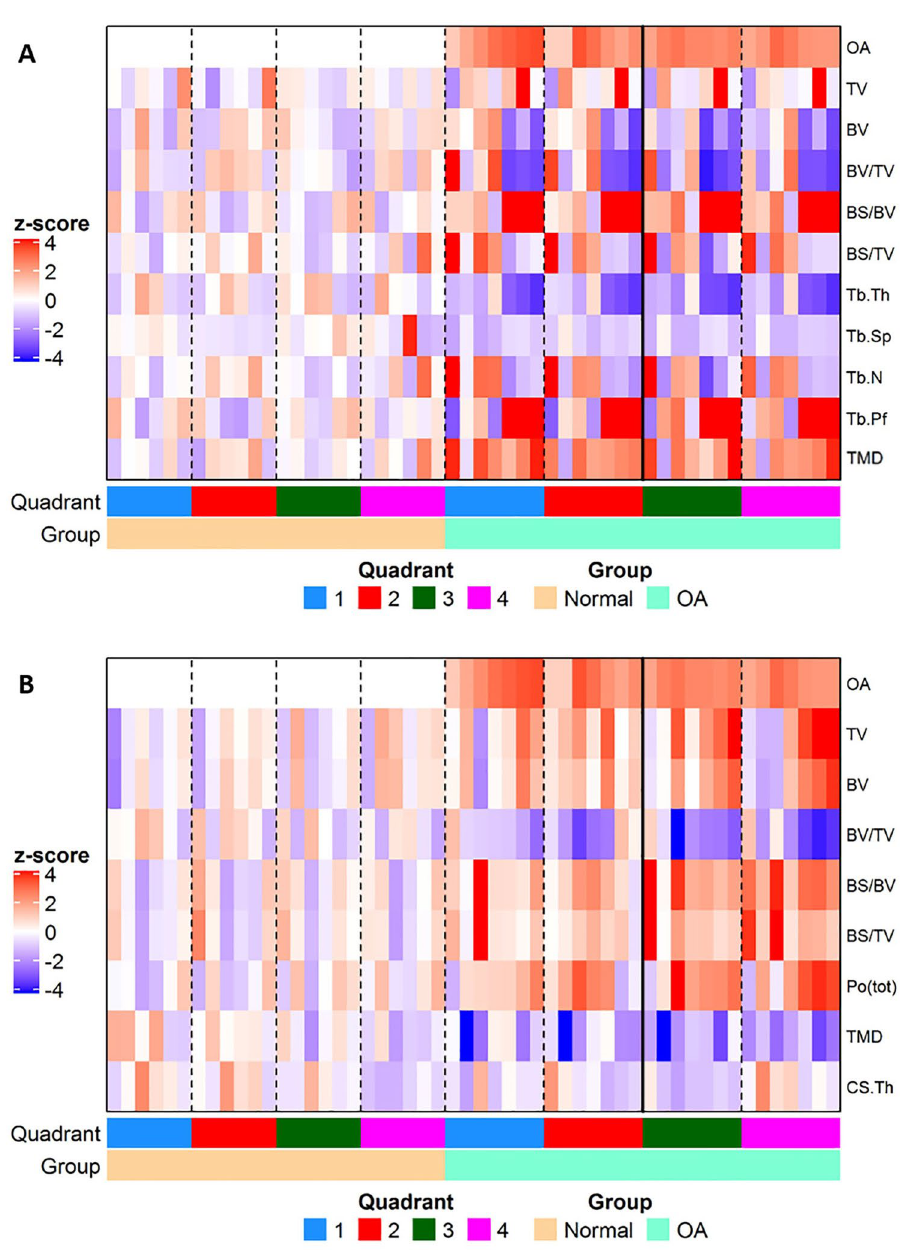
Figure 4. Heat maps showing differences in structural parameters of ( A ) trabecular bone and ( B ) subchondral plate in the four anatomical regions defined in both OA and non-OA samples. Patients were grouped according to disease status; all measurements were standardized (subtract mean and divide by standard deviation of non-OA controls) as indicated by z-scores (deeper red indicated higher readout and deeper blue indicated lower